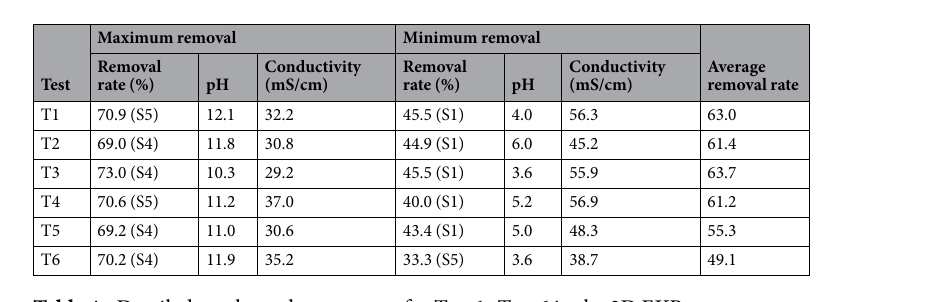
Table 4. Detailed results and parameters for Test 1–Test 6 in the 3D EKR